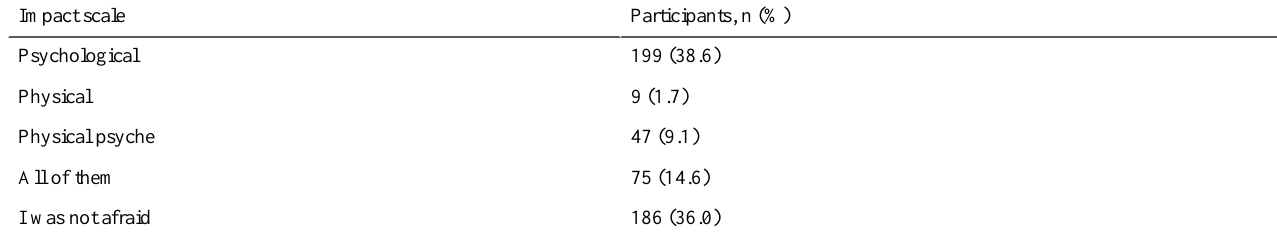
Table 5. Impacts of fear on study participants